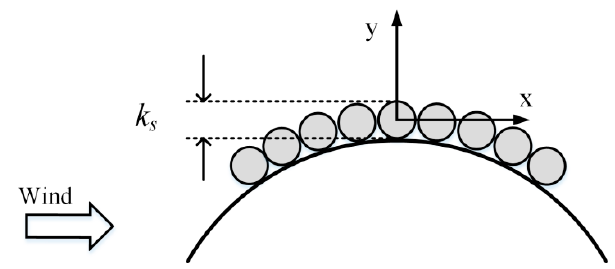
Figure 4. Schematic of the equivalent sand model.